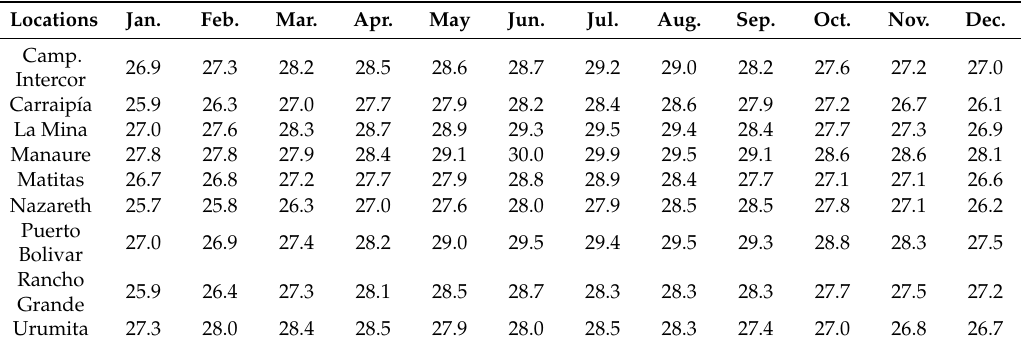
Table 1. Temperature [ ◦ C] matrix for the di ff erent measurement points in La Guajira [22]. Locations